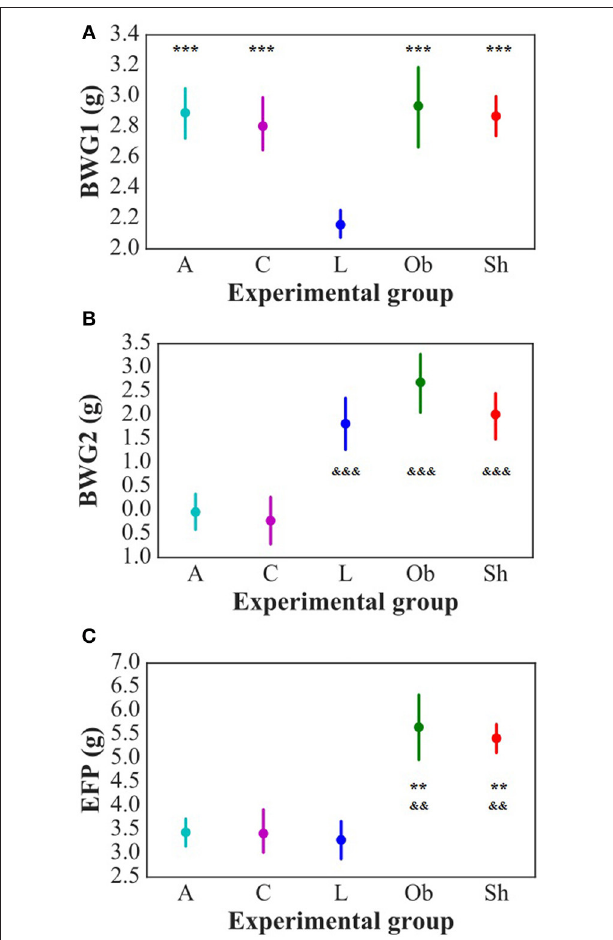
FIGURE 2 | Daily average body weight gain in pre-stimulation period (BWG1) [g/day] (A) and during stimulation period (BWG2) [g/day] (B) of the study as well as epididymal fat-pads weight (EFP) [g] (C) . L, lean intact ( n = 11); Ob, obese intact ( n = 10); Sh, obese with sham stimulation ( n = 11), A, obese with anodal stimulation of the right prefrontal cortex ( n = 14); C, obese with cathodal stimulation of the left prefrontal cortex ( n = 11). Data are presented as the mean ± SD. ** P < 0.01 vs. L; *** P < 0.001 vs. L; && P < 0.01 vs. A and C; &&& P < 0.001 vs. A and C. The differences between the groups were analyzed with one-way ANOVA followed by the Tukey post-hoc test (BWG) or Kruskal-Wallis test followed by the Dunn post-hoc test (EFP).